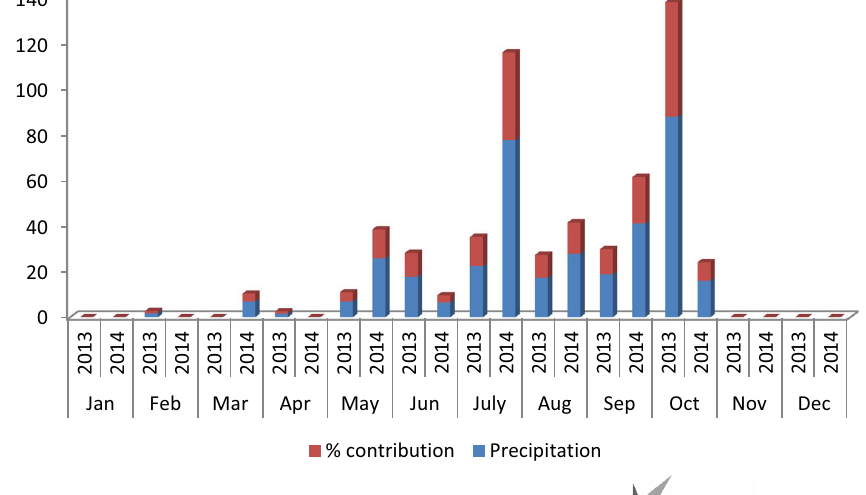
Fig. 1 Total rainfall and % con- tribution to the pond water for each month of 2013 and